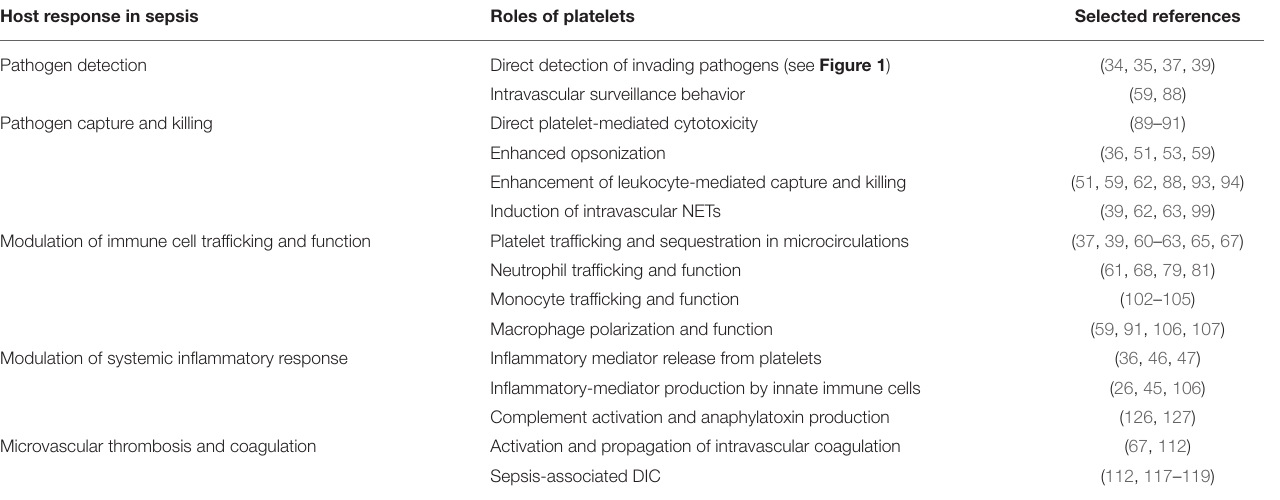
TABLE 1 | The role of platelets in host defense during bacterial infection in the